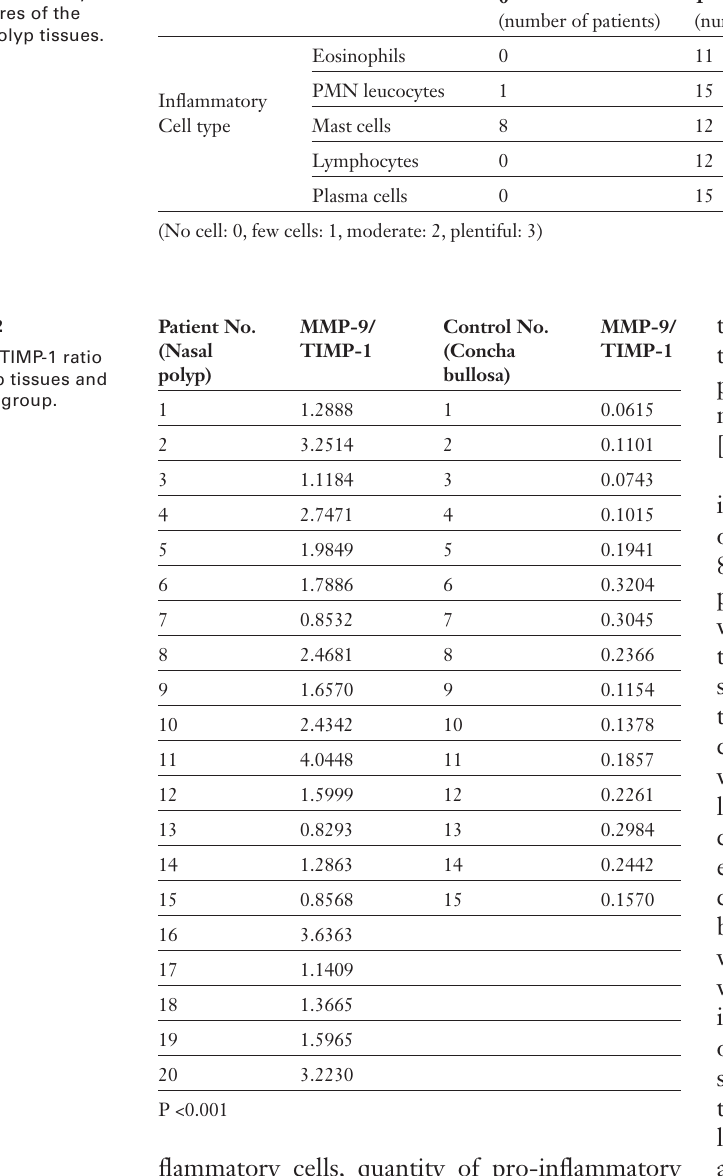
Table 1 The inflammatory cell scores of the nasal polyp tissues.